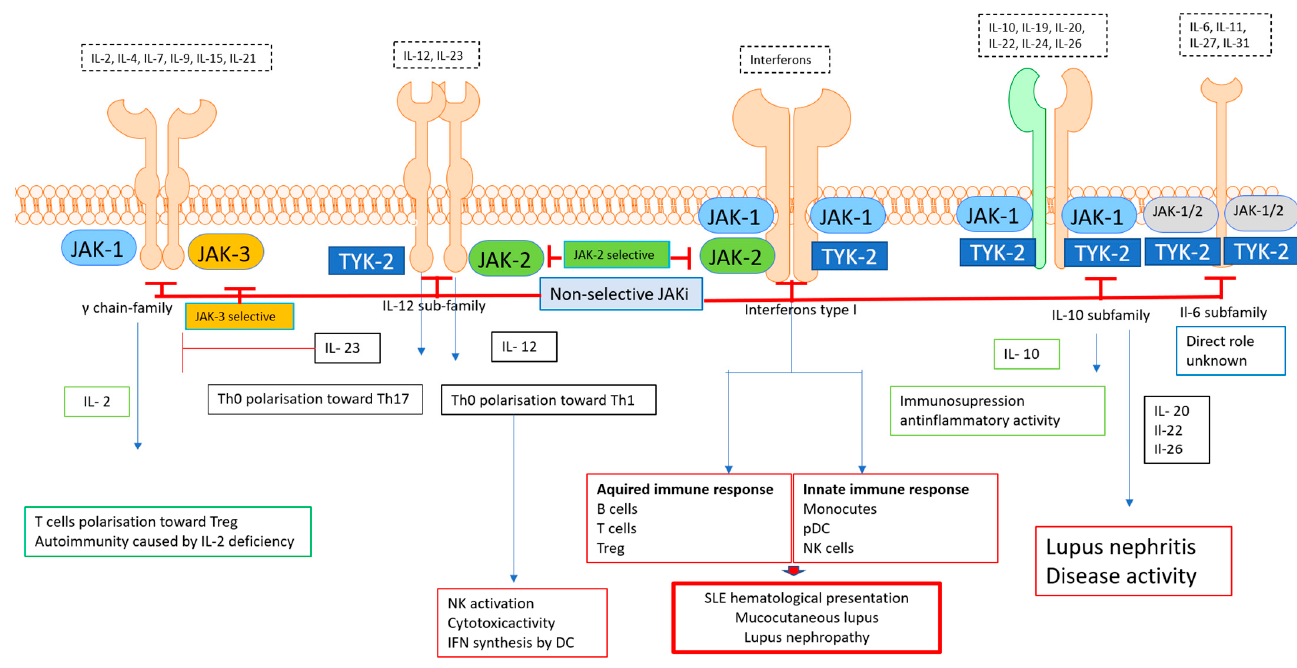
Figure 2 . The role of cytokines in SLE. Figure 2. The role of cytokines in